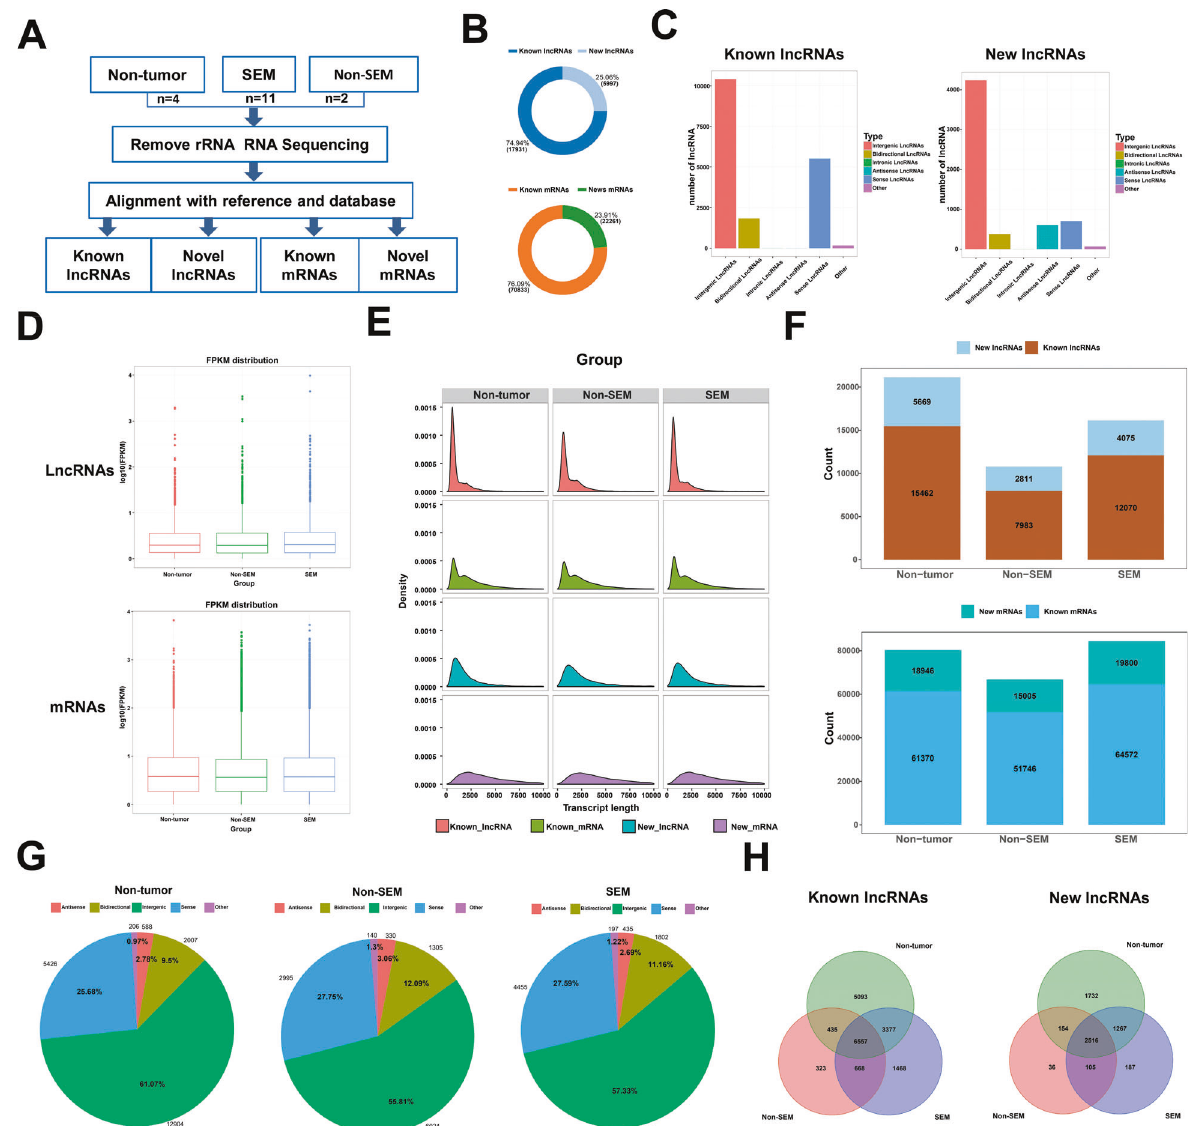
Fig. 1 Overview of lncRNA Expression in TGCT Samples. A RNA sequencing fl owchart. B Abundance of known lncRNAs to novel lncRNAs (top) and the ratio of known mRNAs to novel mRNAs (bottom). C Type abundance diagrams of known (left) and novel (right) lncRNAs. D Box plots of transcript expression levels in each group. E Length distribution density diagrams of known mRNAs and new mRNAs (pink and blue) and known lncRNAs and new lncRNAs (green and purple). F Distribution of the number of known lncRNAs and novel lncRNAs (top) and the number of known mRNAs and novel mRNAs (bottom) in each group. G Pie charts of the distribution of lncRNA types in the different groups of samples. H Wayne diagrams of known lncRNAs (left) and new lncRNAs (right) in each